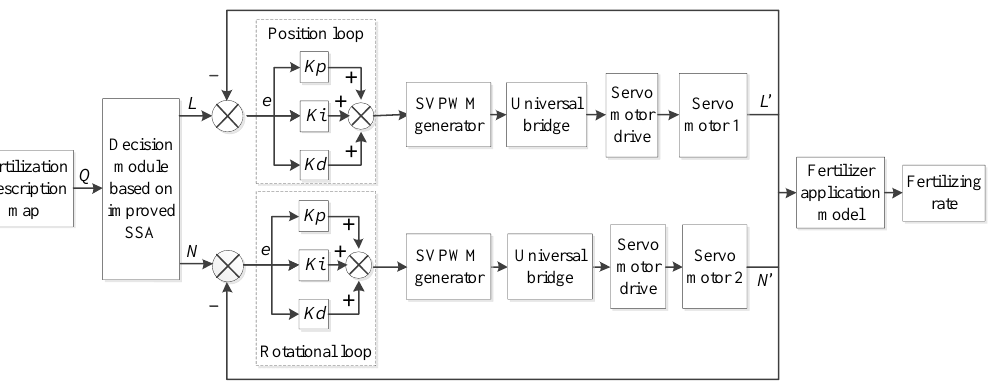
Figure 3. Control block diagram of regulation parameters.